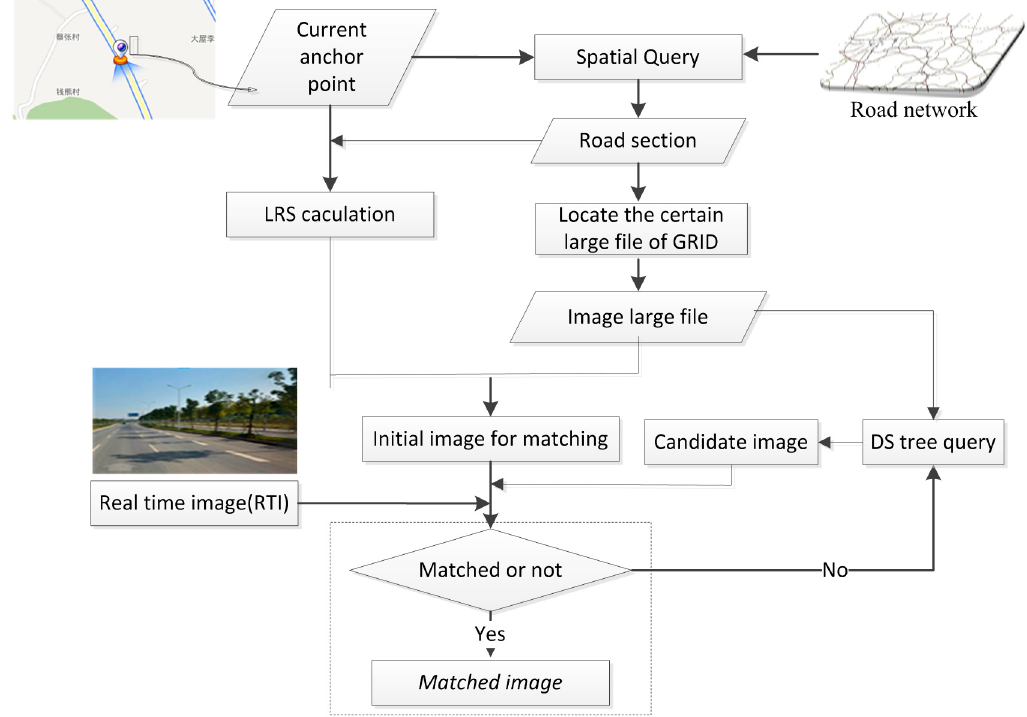
Figure 5. Fast search and large file location based on spatial query.